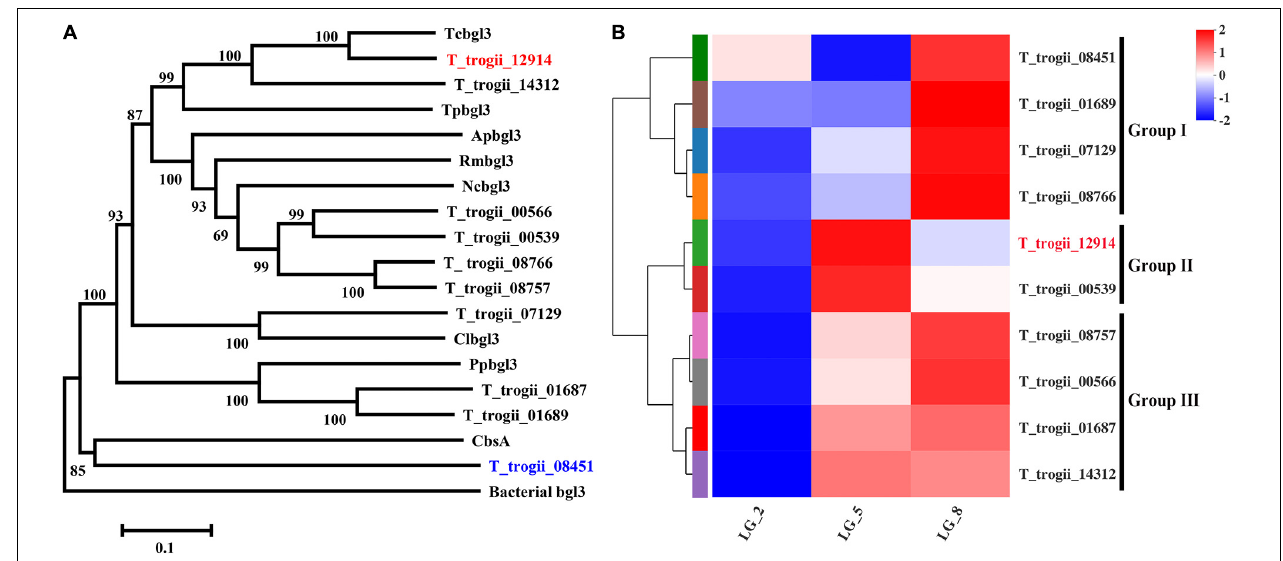
FIGURE 1 | Phylogenetic analysis and the expression profles of the GH3 gene family. (A) Phylogenetic analysis of the GH3 gene family members of T. trogii S0301. The scale bar represents 0.1 substitutions per site. Phylogenetic analysis was conducted using MEGA6 software. (B) The expression profles of GH3 gene family members in GYP medium added with 0.5% lignocellulose and 0.5% glucose.